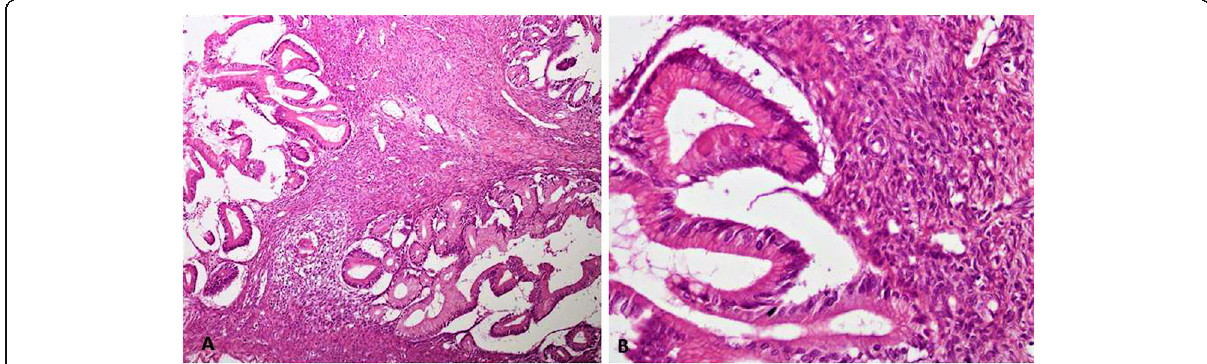
Fig. 3 a , b Histologically, mucinous cystic neoplasms are lined by tall columnar epithelium with basally placed mildly atypical nuclei and hypercellular subepithelial